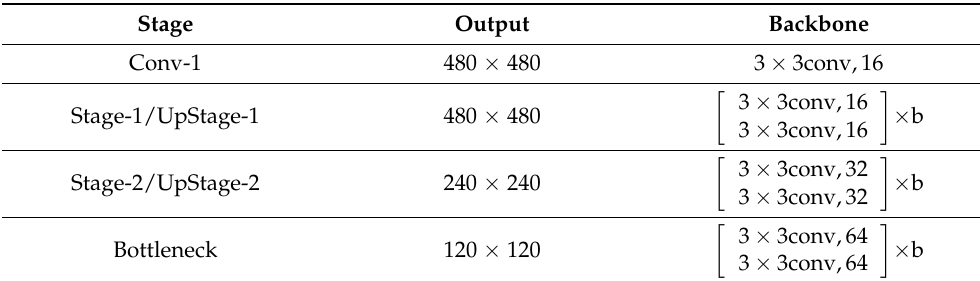
Table 1. EAAU-Net Table 1. EAAU-Net backbones.